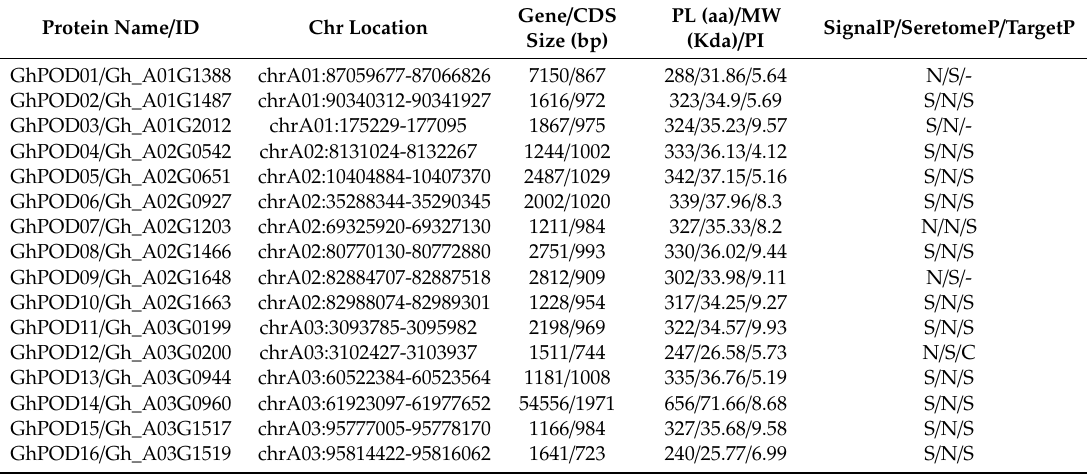
Table 1. The 198 POD genes identified in cotton and their sequence characteristics and